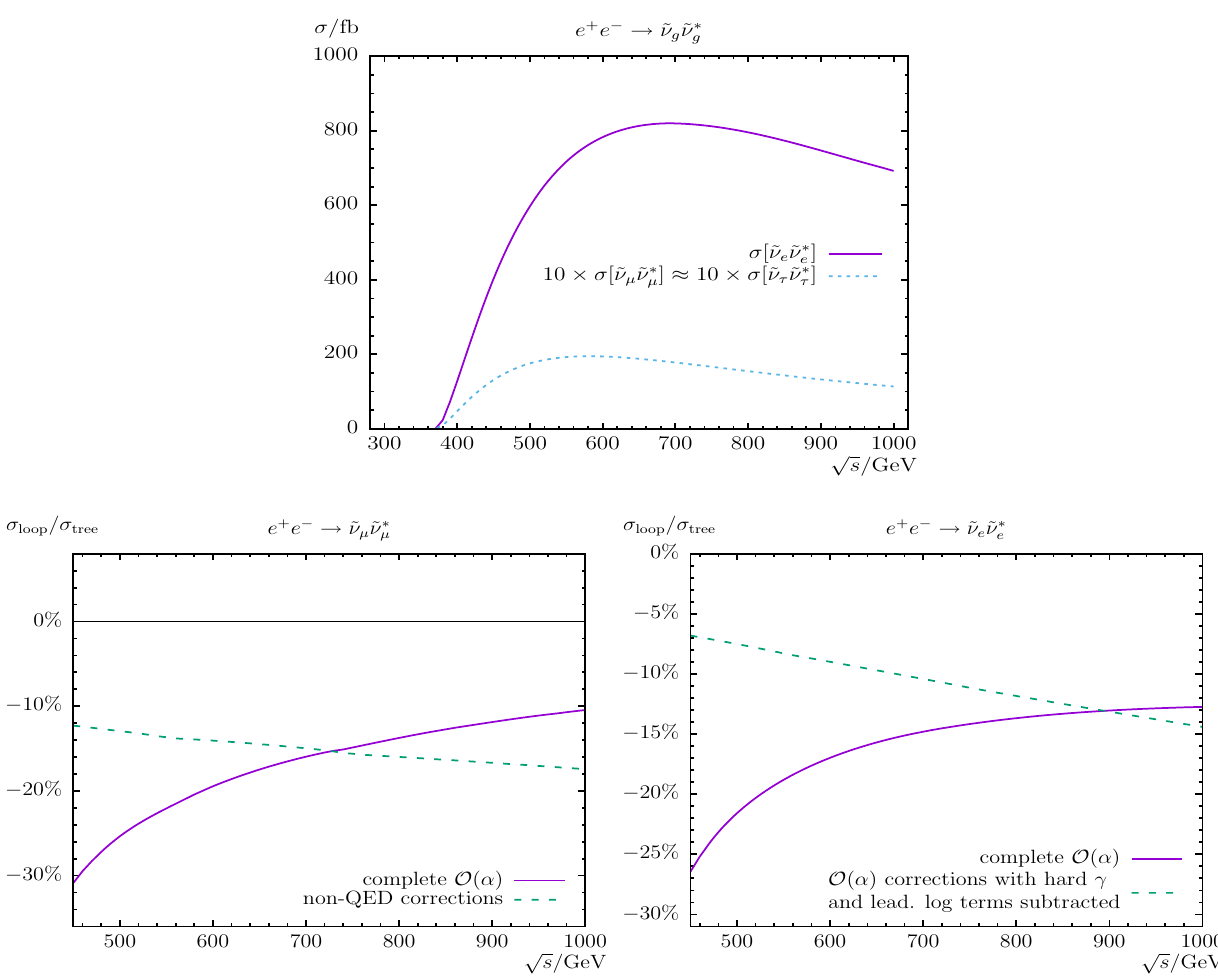
Fig. 5 Comparison with Ref. [40] for e + e − → ˜ ν g ˜ ν ∗ g . Born cross sections (upper plot) and complete relative one-loop results (lower row) are shown for the SPS1 a parameter point as given according to Ref. [40] as a function of